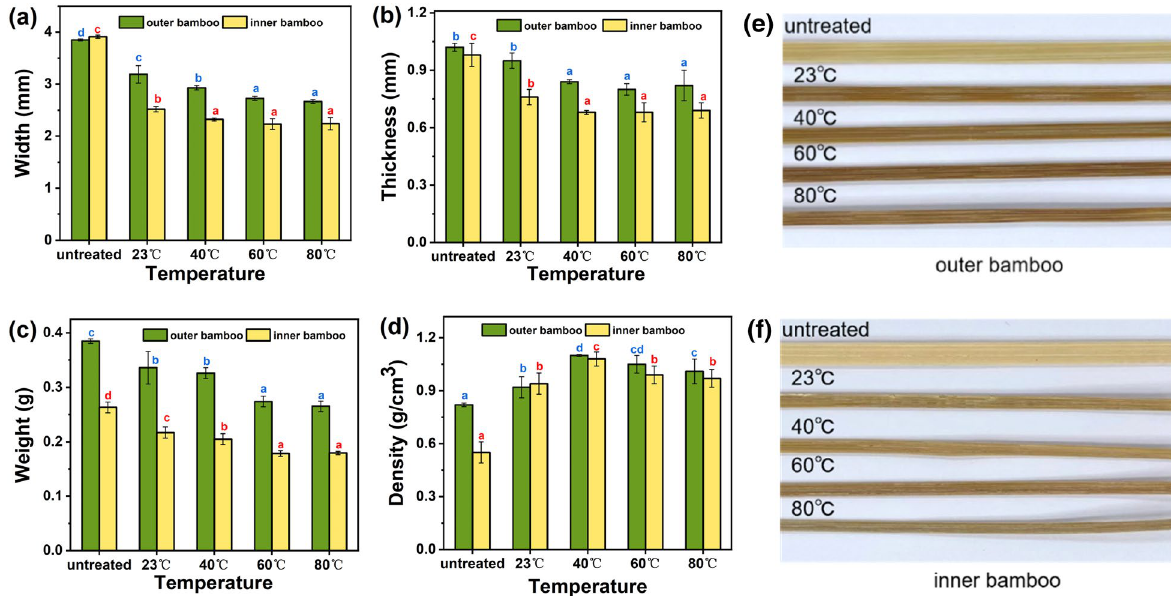
Fig. 5 Changes in dimension and morphology of bamboo slivers after alkali treatment at different temperatures. a Width; b thickness; c weight; d density; e morphology of outer bamboo slivers; f morphology of inner bamboo